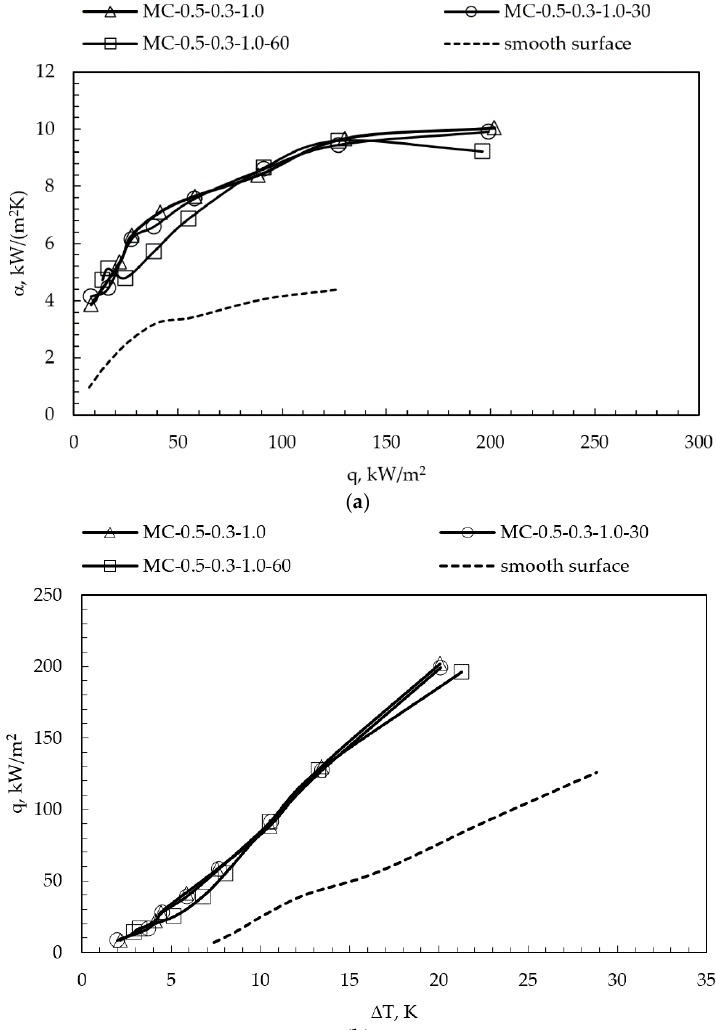
Figure 7. Pool boiling curves for NOVEC-649, width of microchannel 0.4 mm. ( a ) Pool boiling heat transfer; ( b ) boiling curves.